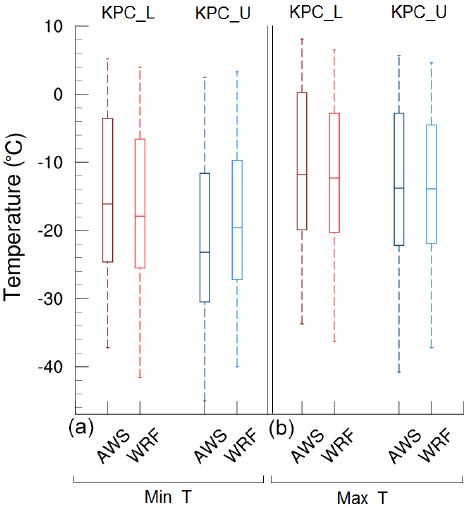
Figure 6. Box plot representing the minimum (a) and maximum (b) daily temperature values at the KPC_L (red) and KPC_U (blue) lo- cations, from both observations (darker colours) and WRF (lighter